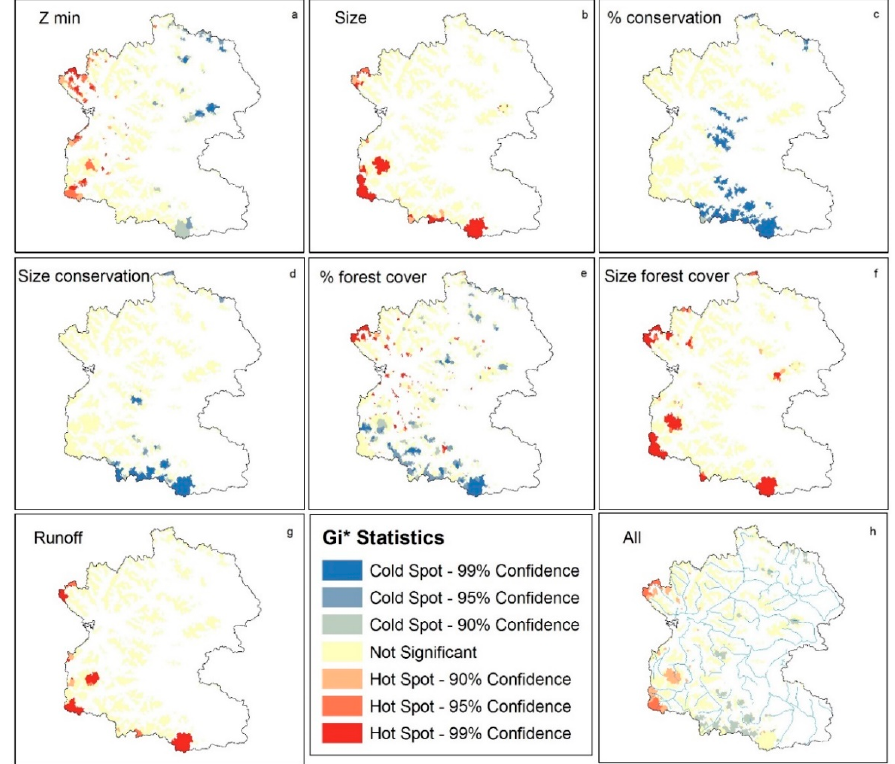
Figure 8. Example of IFW conservation assessment and prioritization for the Aysén watershed. Shown are Gi* indices for select physical attributes (minimum elevation Z min, clustered size), forest attributes (% forest cover, forest patch size), conservation status (% conservation cover, size of conservation clusters) and hydrology (runoff). A combined Gi* index is shown, assuming equal weight for each individual index (see text).